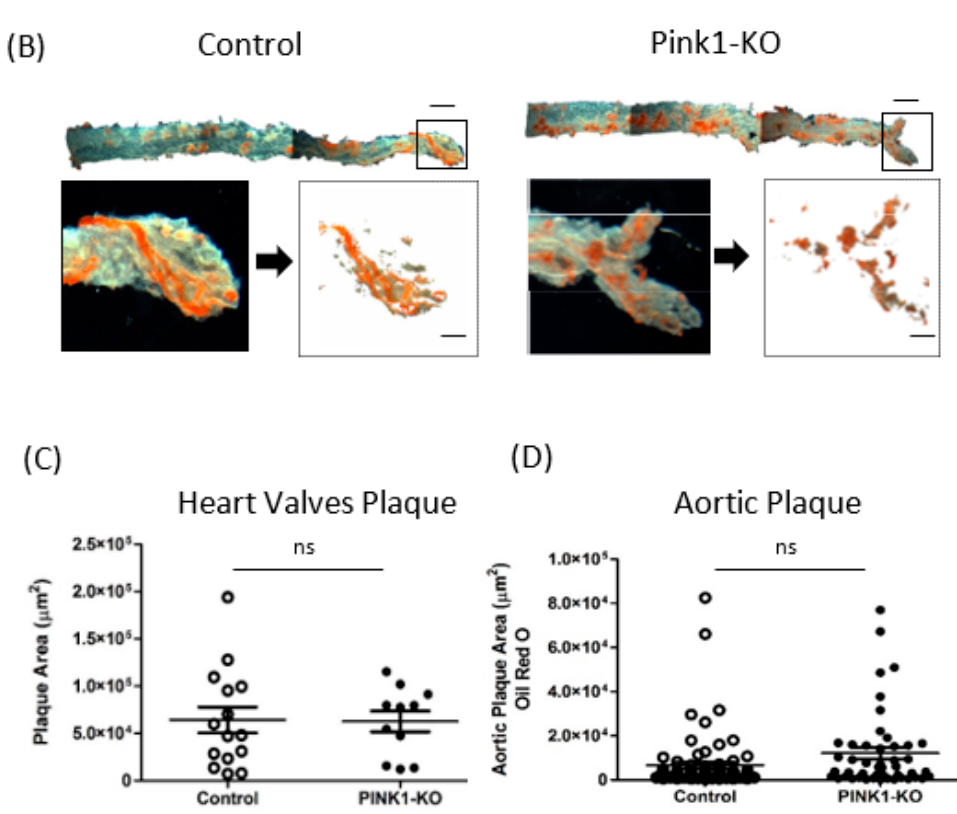
Figure 3. Pink1-KO ApoE − / − mice have features of increased plaque vulnerability. Heart aortic root valves were sectioned at the coronary outflows and assessed for plaque quantity and quality. ( A ) Gross plaque structure and abundance of VSMC and macrophages, elastin andcollagens, hexII and Pink1 expression in plaque cap and IgG2A isotype controls (Olympus CellSenS) (scale 2 mm), control n = 9, Pink1-KO n = 15. ( B ) Representative whole aortae were taken from the aortic arch to the femoral bifurication and stained for total plaque burden with Oil red O, en face preparation (scale bar 500 µm). ( C ) Heart aortic valve (sinus) plaque cross-sectional area then quantified between groups. ( D ) Frequency of all discrete luminal surface aortic plaques were digitally extracted and plotted between control and Pink1-KO mice (Student t -test p ≥ 0.05, ns—not significant).